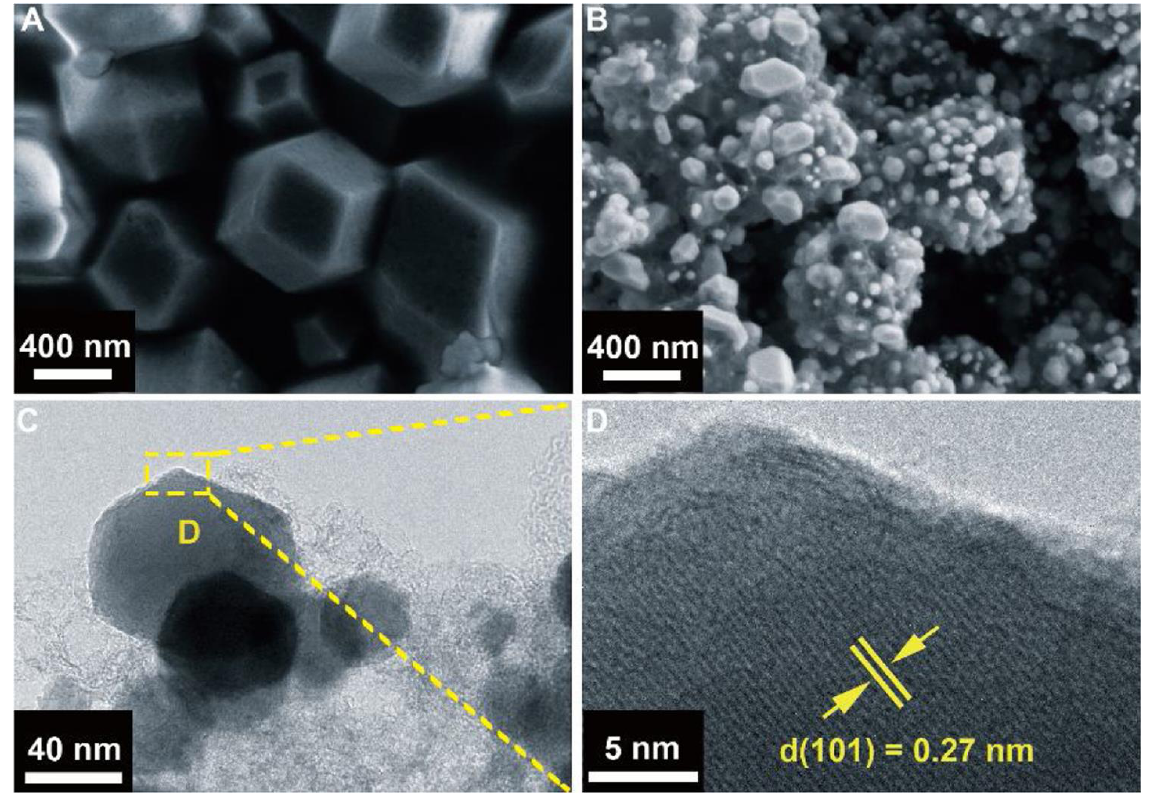
Figure 6. ( A ) SEM image of CuCo-ZIF-0.5, ( B ) SEM image of (CuCo)Se/C-0.5, ( C ) TEM and ( D ) HRTEM images of (CuCo)Se/C-0.5, respectively [67]. Copyright 2021 Elsevier. Similarly, Liang et al. [68] synthesized hierarchical (Ni 0.33 Co 0.67 )Se 2 complex hollow spheres (CHSs) with a hierarchical porous surface. The fabrication process involves an- nealing for transforming the solid spheres of Ni-Co-MOF onto NiCo 2 O 4 multi-shelled